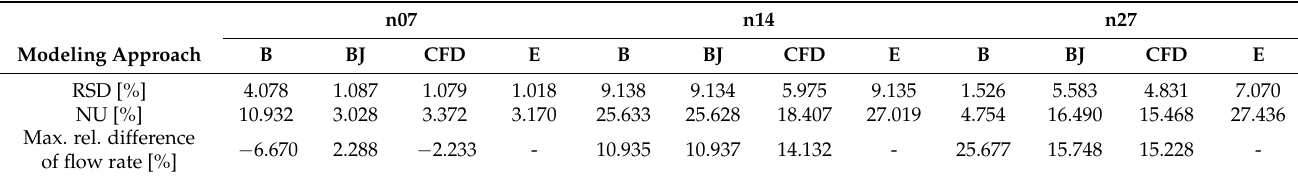
Table 6. Flow distribution as predicted by the examined modeling approaches and observed in experiments. n07 n14